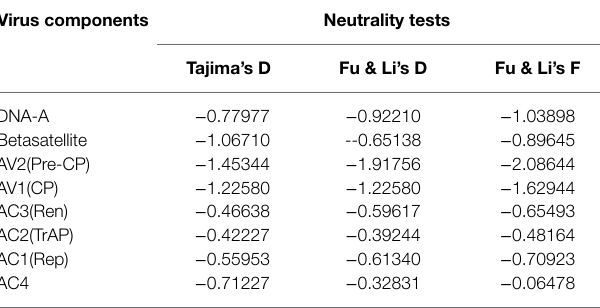
D is the Tajima test statistic estimates neutral mutation hypothesis using DNA polymorphism; Fu and Li’s D * and Fu and Li’s F * : Detecting neutrality of mutations among DNA